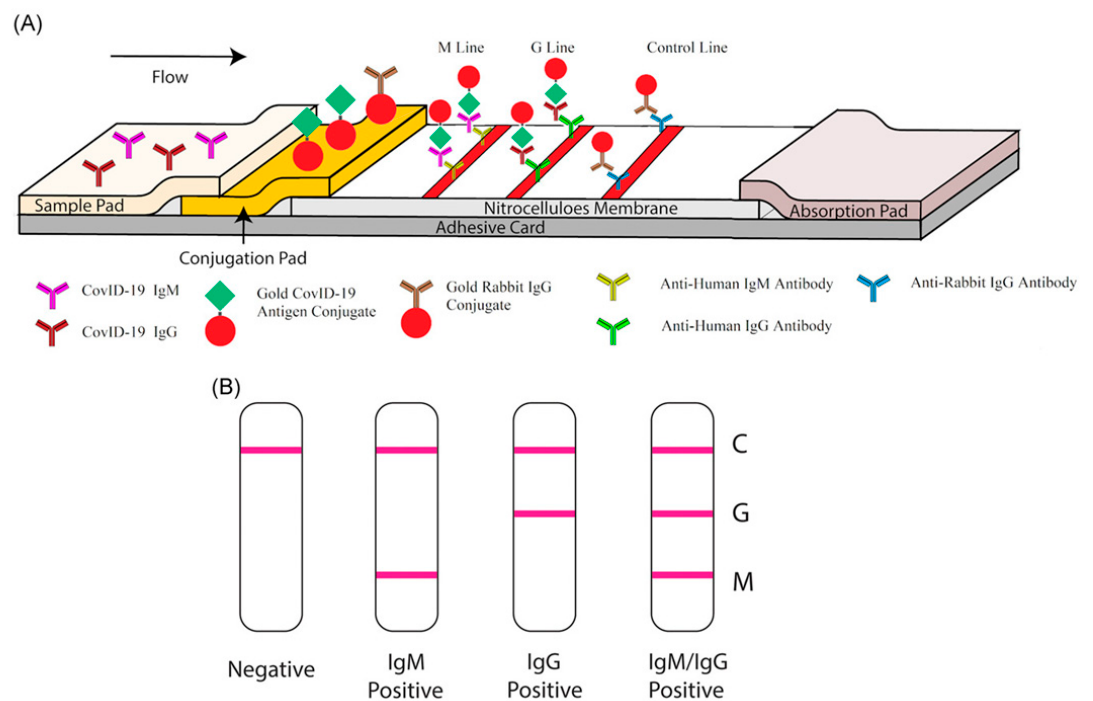
Figure 5. Lateral flow immunoassay for the detection of anti-SARS-CoV-2 antibodies [21]. The sample fluid flows laterally along the strip, which includes di ff erent zones such as conjugation pad, adhesive pad, and absorption pad. The conjugation pad includes antibodies for the target analyte and antibodies conjugated with signal molecules (fluorescent particles and gold particles). The nitrocellulose membrane contains the testing lines (IgG and IgM lines) and the control line. The last zone is the absorption pad, which prevents the backflow of the liquid. Adapted by permission. Copyright of Li Z. et al.